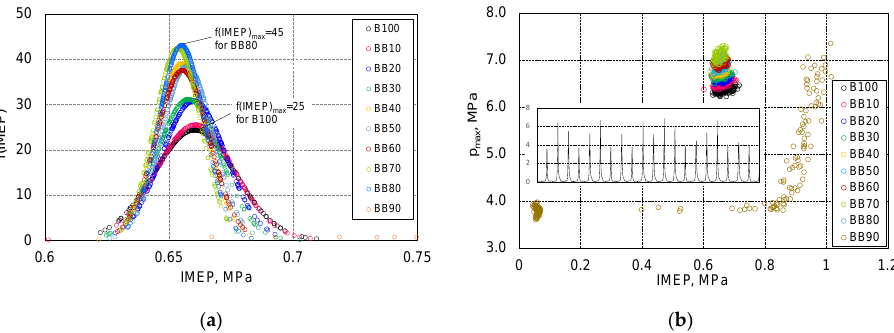
Figure 8. Probability density of indicated mean effective pressure ( a ) and relationship between IMEP and p max ( b ). For parametric evaluation of the combustion process in a reciprocating engine, three characteristic stages are taken into account. Their values are a source of valuable infor- mation for the engine control system. These characteristic stages of combustion are: igni- tion delay time, angle after TDC of 50% of heat release and conventional end of combus- tion. The time of ignition delay, characteristic for a given engine and the fuel consumed in it, should be taken into account when determining the angle of the beginning of fuel injection into the combustion chamber of the engine. Determining the angle of 50% heat release gives information about the efficiency of the engine. According to the literature, in an engine in which 50% of heat is released about 8–10 degrees aTDC, such an engine